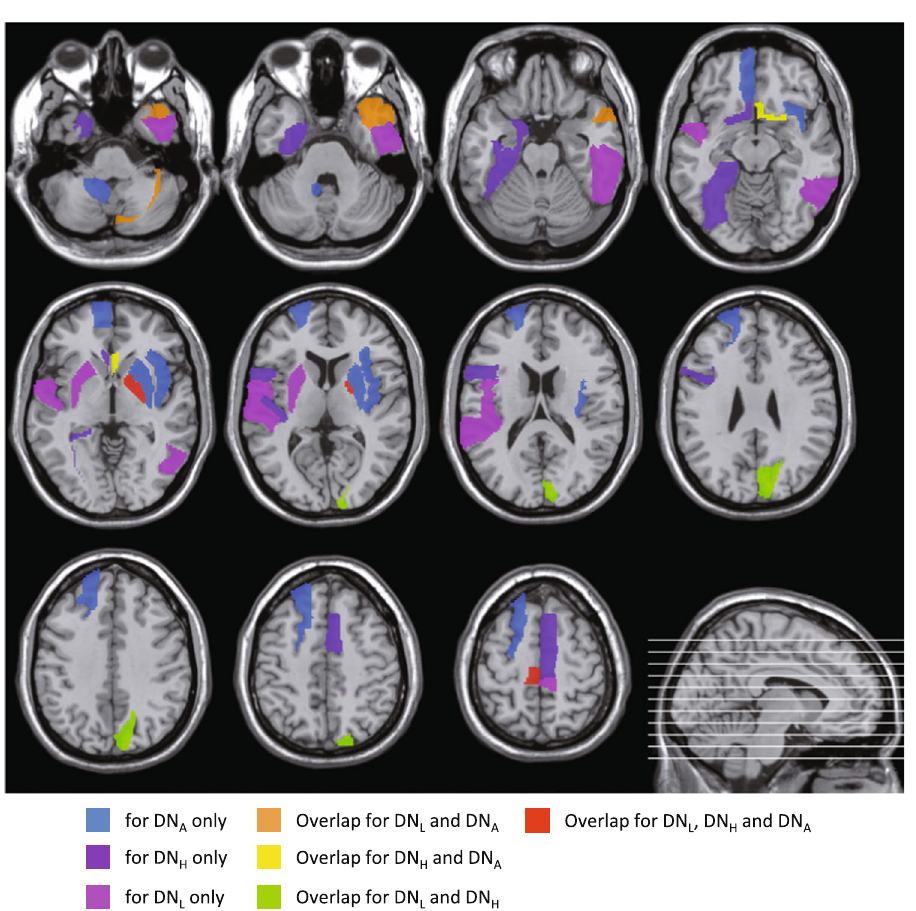
Figure 7. ROIs with the top ten principal component coefficients corresponding to the most discriminative features selected by LASSO for DN L , DN H and DN A ,